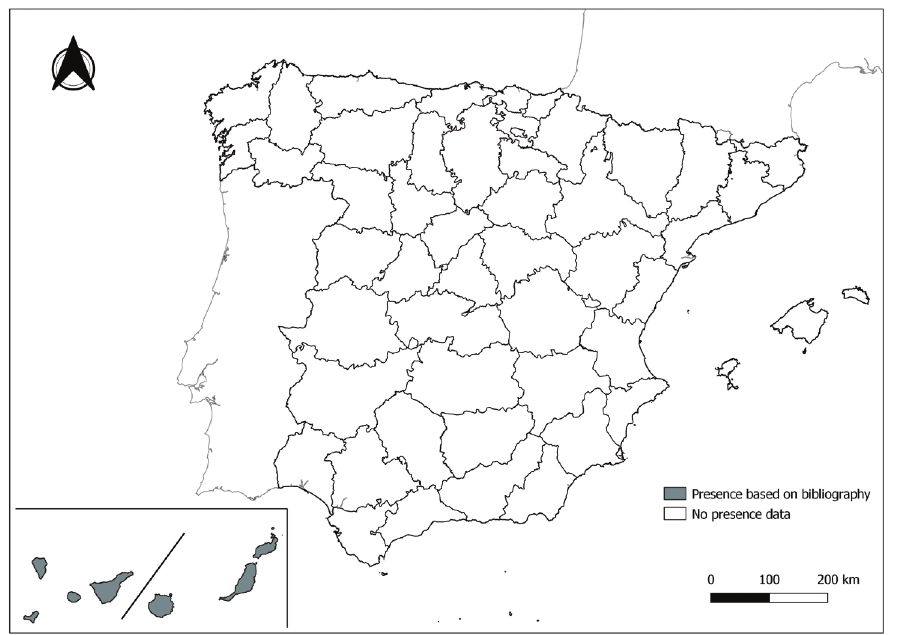
Figure 12. Distribution of Sergentomyia fallax in Spain. Note its absence from peninsula